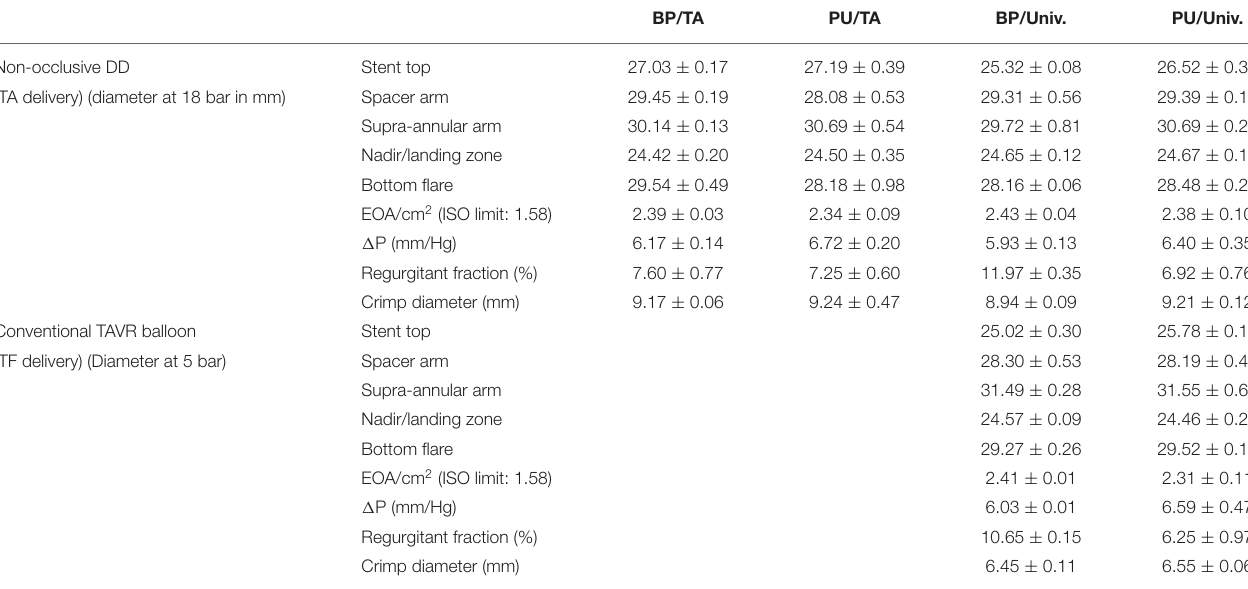
TABLE 1 | Dimensional and hemodynamic characteristics of SAT TAVR [transapical (TA) and universal (Univ)] comparing bioprosthetic (BP) with polymer (PU) leaflets, in combination with the non-occlusive trans-apical delivery system (TA-DD) or a conventional trans-femoral (TF) delivery